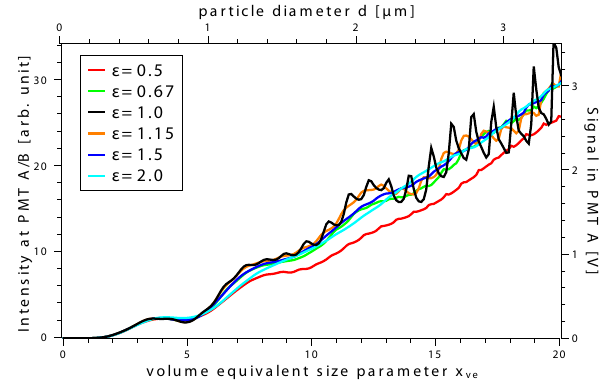
Fig. 4. Intensity integrated over the detector area without a polar- from randomly ori- C izer within the optical pathway (PMT A/B) I d from sphere volume-equivalent C equivalent size parameter x ve for orientation-averaged spheroids with different aspect ratios (cid:15)